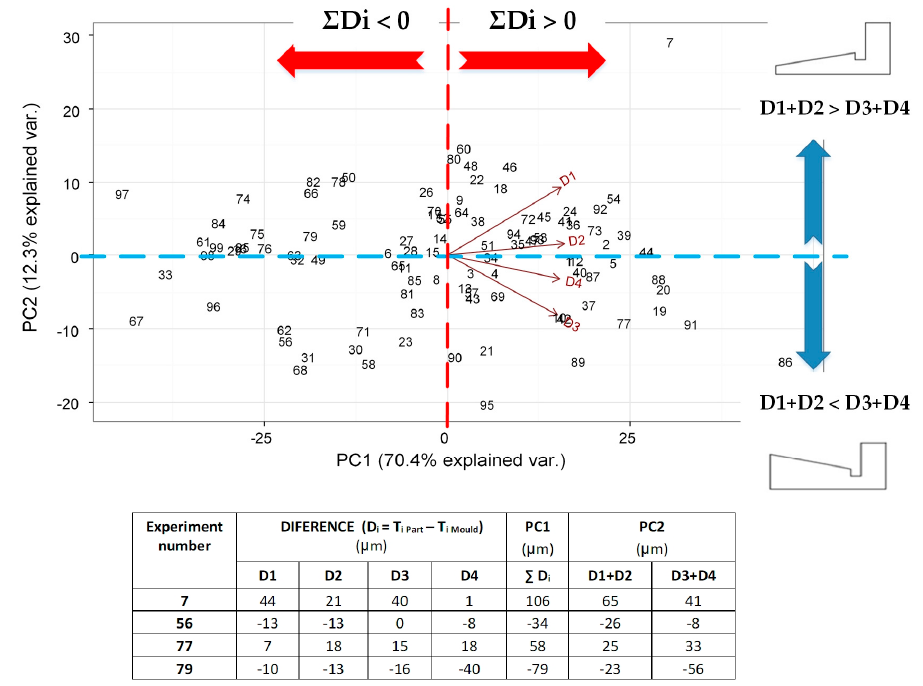
Figure 7. Biplot resulting from principal component analysis of Di, where D i = T i Part—T i Mold, i = 1…4 measured at four different part points.